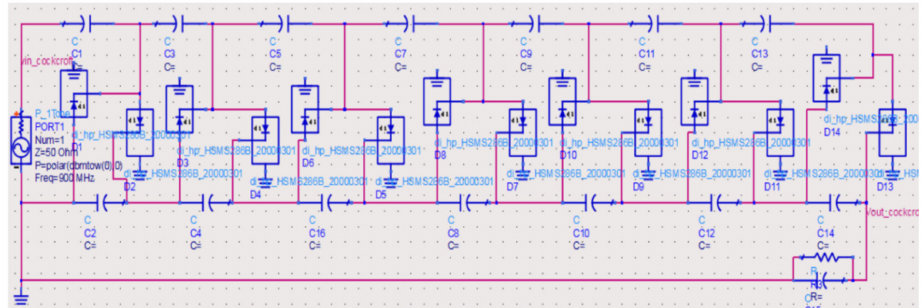
Figure 11. Simulation of the proposed design using Advanced Design System (ADS)